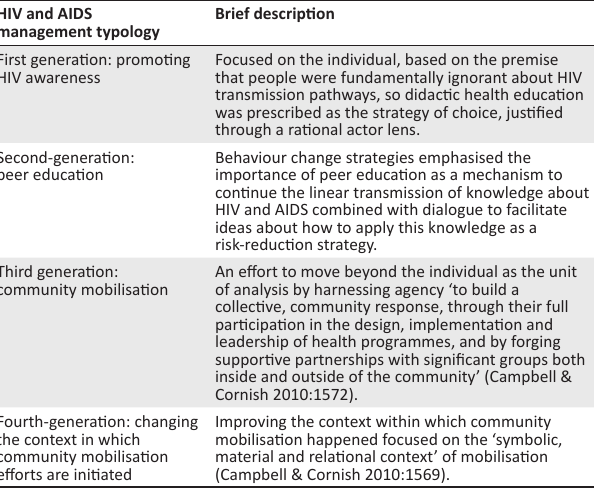
TABLE 1: Four generations of human immuno virus and acquired immune deficiency syndrome